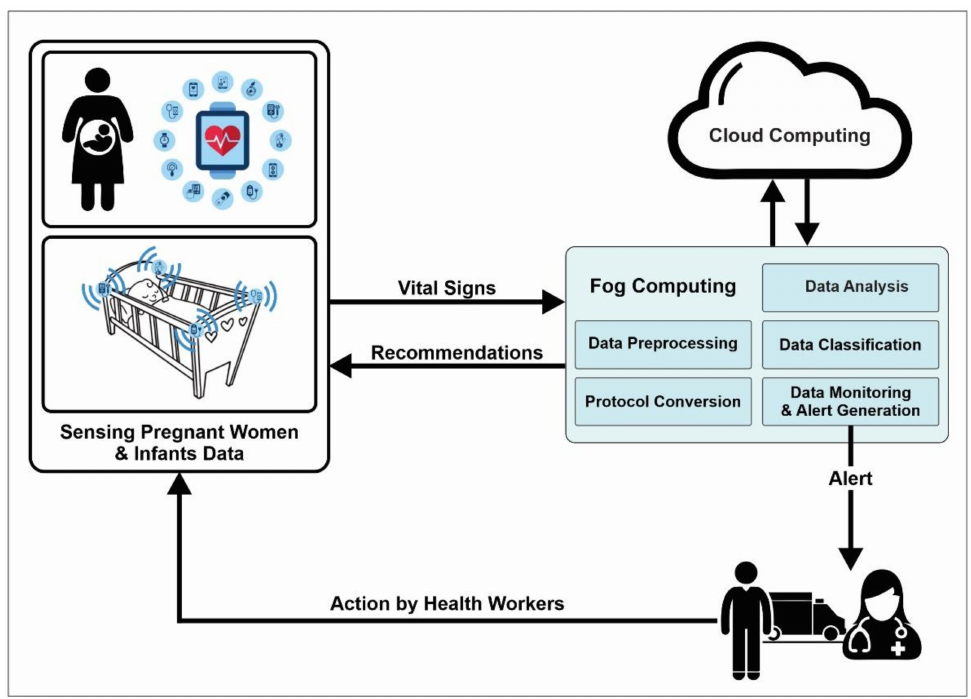
Figure 2. Architecture of healthcare